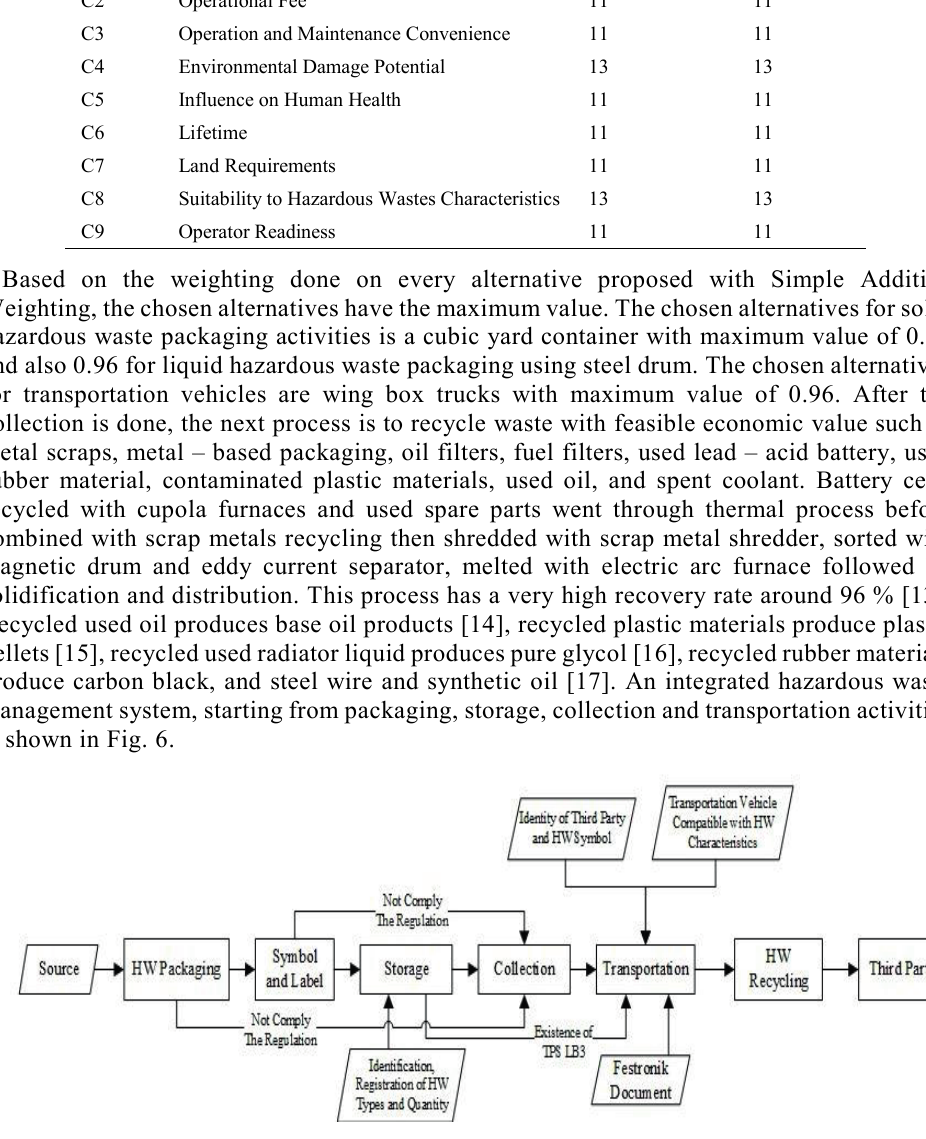
Fig. 6. Integrated management system of automotive shops hazardous waste in Bandung